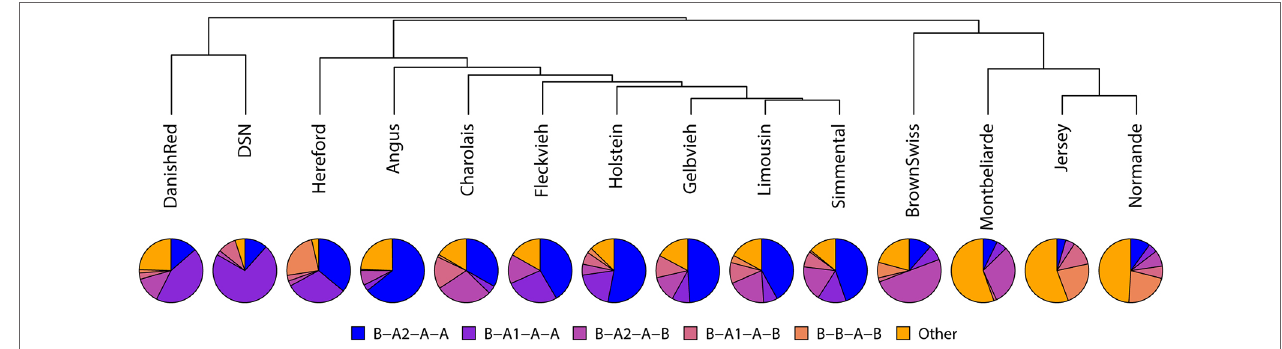
FIGURe 3 | Haplotype analysis across the casein proteins CSN1S1-CSN2-CSN1S2-CSN3 for the five most common haplotypes listed using the respective protein variant names. Haplotypes with a total frequency less than 5% are summarized as